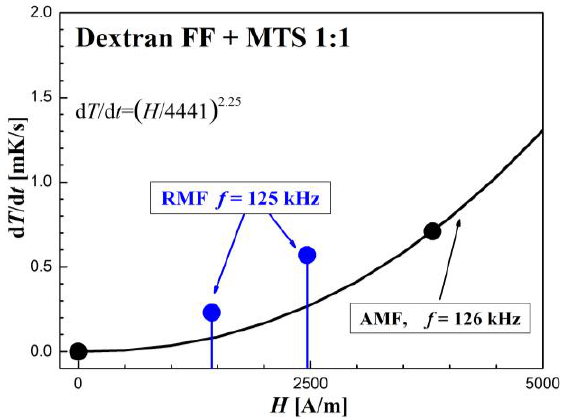
Figure 14. Comparison of the d T /d t dependence on the amplitude of the intensity H measured in rotating and oscillating magnetic field in the sample of Dextran FF + MTS (in a ratio 1:1).